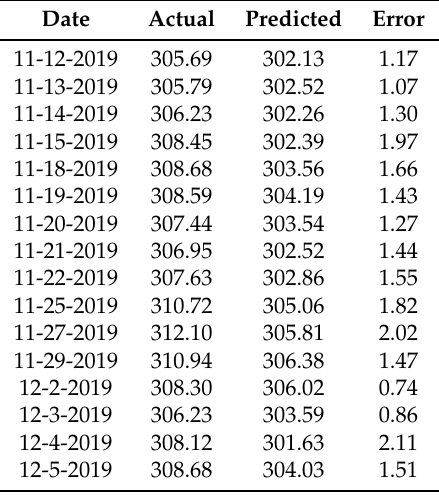
Table 8. Prediction by ANN (7-15-1)